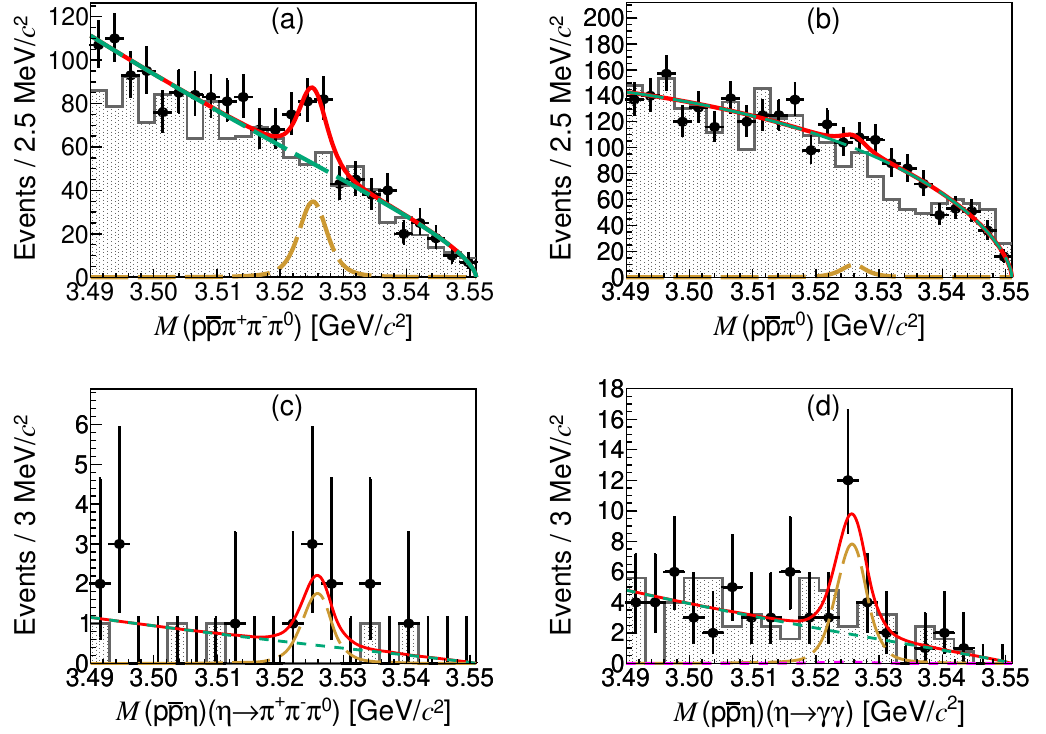
Figure 1 . Fits to the invariant mass spectra of (a) p ¯ pπ + π − π 0 and (b) p ¯ pπ 0 and simultaneous fits to the invariant mass spectra of (c) p ¯ pη with η → π + π − π 0 and (d) η → γγ for data. Data are shown as points with error bars, the total fit result is shown by the red solid line, the background contribution is denoted by the green dashed line (including the peaking background contribution shown barely discernible in pink in (d)), and the signal contribution is illustrated by the gold dashed line. The background obtained from inclusive MC samples is shown by the gray shaded